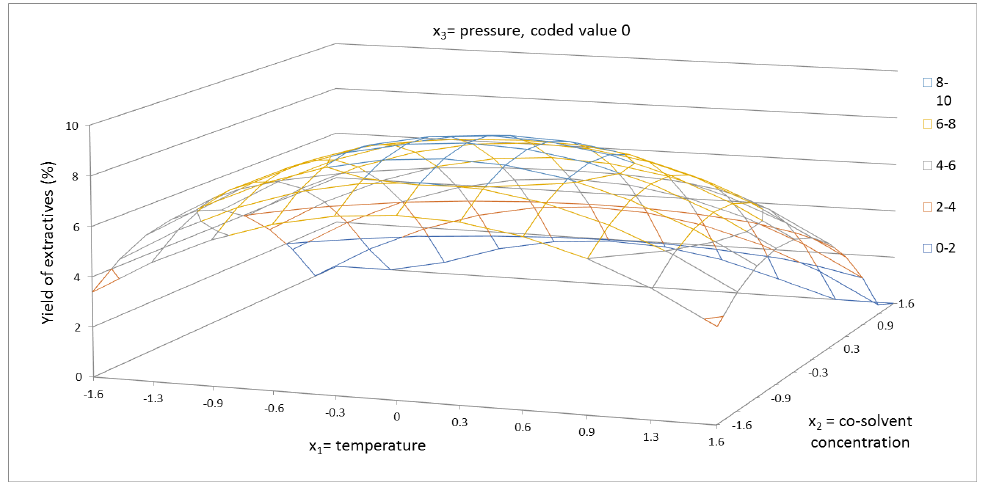
Figure 1. Response surface of extractives yield (%) as a function of temperature in range of 40–100 °C and cosolvent concentration of 40–96.6% EtOH/water, in coded values, at constant pressure of 5025 psi (coded value 0).